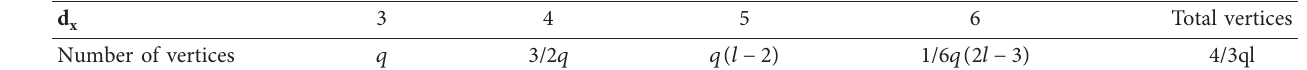
NT ). α lq NT α lq